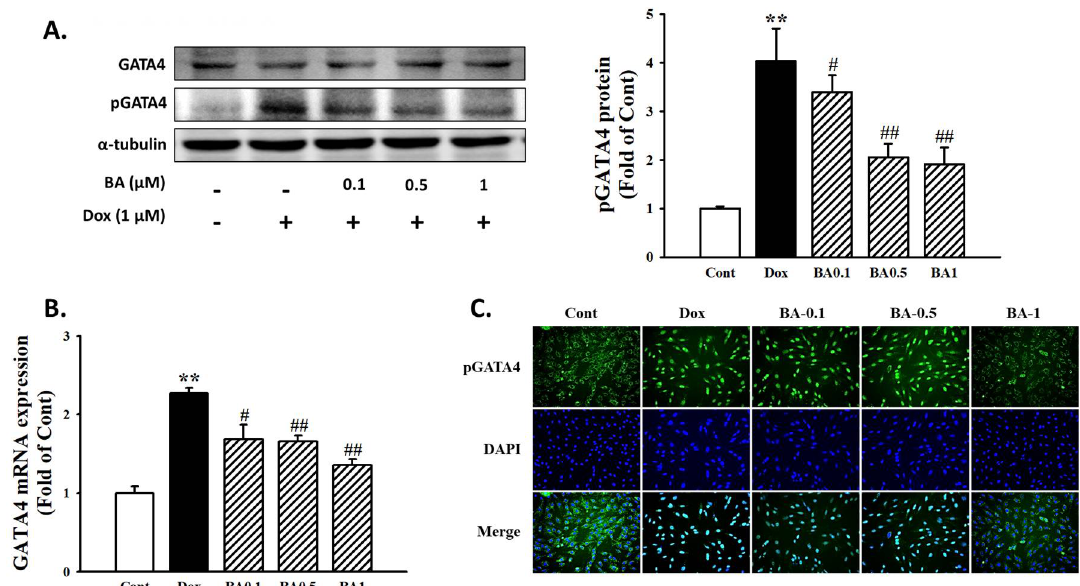
Figure 6 Figure 5. The effects of BA on activation of GATA4. ( A ) The protein levels of GATA-4 and phosphorylated GATA-4 were de- termined by Western blot analysis. ( B ) GATA-4 mRNA level was analyzed by using Real-time PCR. ( C ) Immunofluorescent images of p-GATA-4 nuclear translocation under the laser scanning confocal microscopy were show (magnification 400 × ). Nuclei were stained with DAPI (blue) and p-GATA-4 was stained with Alexa Fluor 488 (green) (Immunofluorescence, 200 × ). The results are expressed as the mean ± SE values of three experiments. ** p < 0.01, vs. control; # p < 0.05, ## p < 0.01, vs. DOX-treated